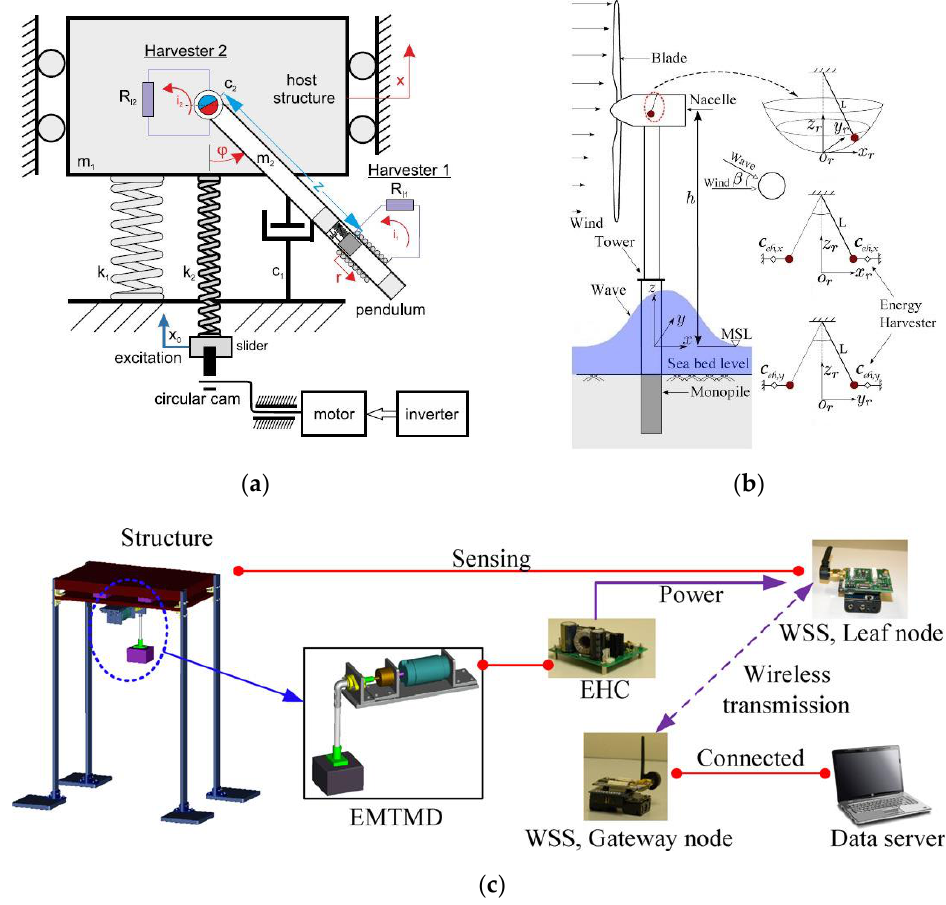
Figure 6. ( a ) Electromagnetic energy harvester with a pendulum-tuned mass damper [59]. Reprinted with permission from Ref. [59]. Copyright 2020, Elsevier. ( b ) OWTs with a pendulum-tuned mass damper [61]. Adapted with permission from Ref. [61]. Copyright 2019, Elsevier. ( c ) Self-powered vibration reduction and monitoring system [62]. Reprinted with permission from Ref. [62]. Copyright 2012, Elsevier.